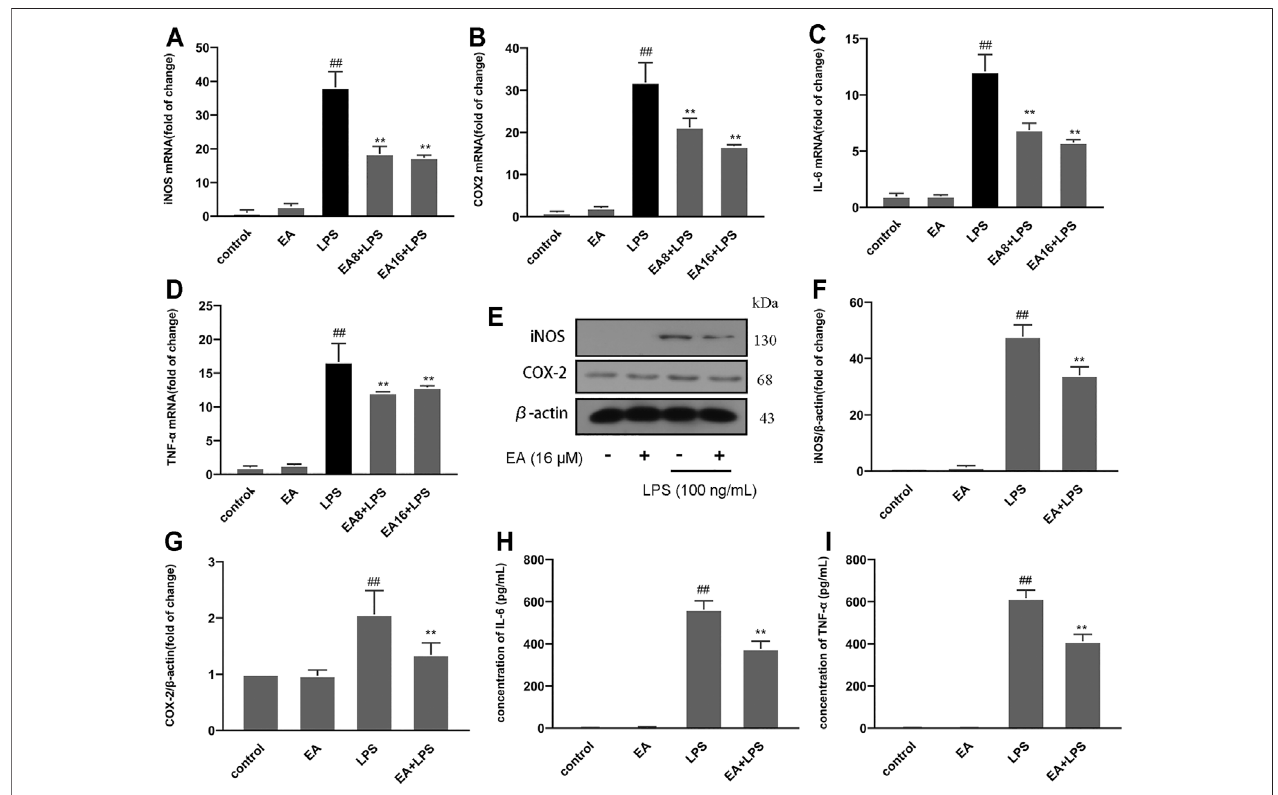
FIGURE2| EAinhibitstheproductionofin fl ammatory mediators.WetreatedBV2cellsfor1 hwithEA(8and16 μ M) andstimulated for12 hwithLPS(100 ng/ml). Then weexamined the effect ofEAon mRNA expression of in fl ammatory mediators [iNOS (A) , COX-2 (B) ,IL-6 (C) , and TNF- α (D) ] via quantitative PCRexperiment. We treated BV2 cells for 1 h with EA (16 μ M) and stimulated for 24 h with LPS (100 ng/ml). Then we examined the effect of EA on protein expression of in fl ammatory mediators[iNOS (E,F) ,COX-2 (E,G) ,IL-6 (H) ,andTNF- α (I) ] via WesternblotandELISAexperiment.Resultsarerepresented asmeans ± SD( n (cid:1) 4). ## p < 0.01 vs. control group. **p < 0.01 vs. LPS-exposed